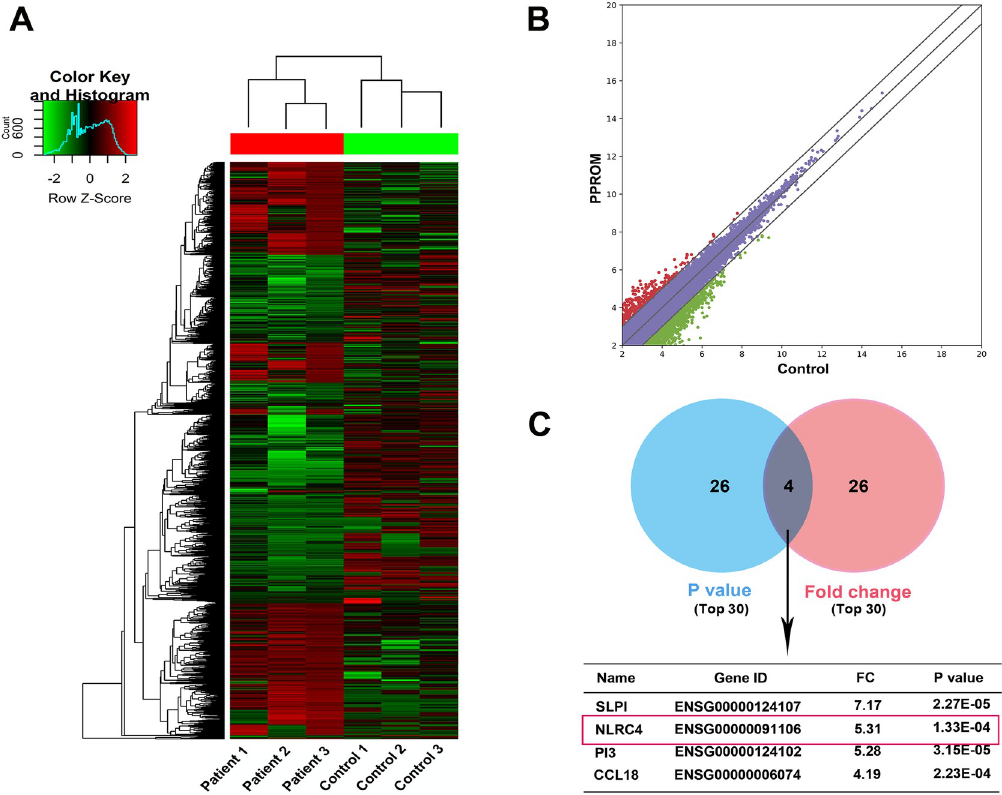
Fig 1. Levels of NLRC4 are increased in PROM. (A) Hierarchical clustering showing differentially expressed mRNAs in membrane tissues of TPROM patients and the normal pregnant (FC < 0.5 or > 2, and P < 0.05); (B) Scatter plots of pairwise comparisons between the Control group and the PROM group; (C) Venn diagram about the top 30 gene sets ranked by P value or FC.